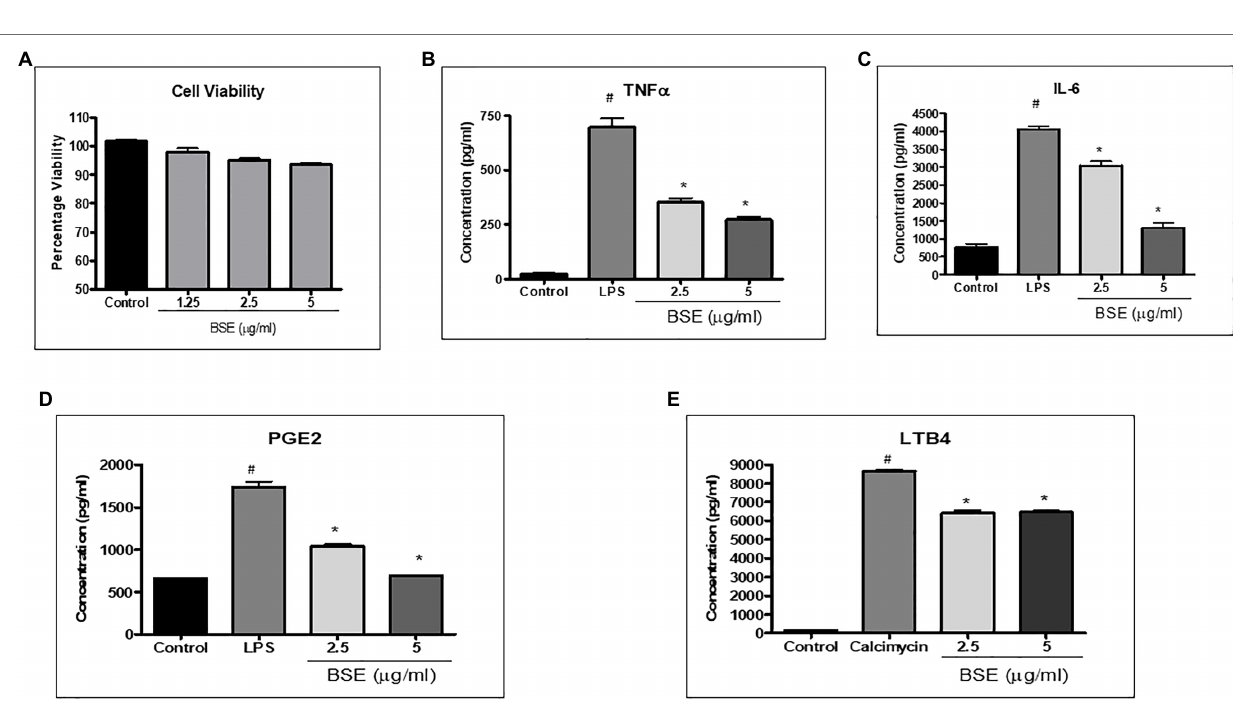
FIGURE 2 | (A) Viability of PMBC cells in the presence of different concentrations of BSE effect of BSE on (B) TNF- α , (C) IL-6, and (D) PGE2 in the supernatant of peripheral blood mononuclear cells (PBMC) activated with bacterial lipopolysaccharides, and (E) LTB4 in the supernatant of peripheral blood mononuclear cells (PBMC) induced with Calimycin. # p < 0.05 compared to control; * p < 0.05 compared to the negative control (LPS for TNF- α , IL-6, and PGE2 and Calimycin for